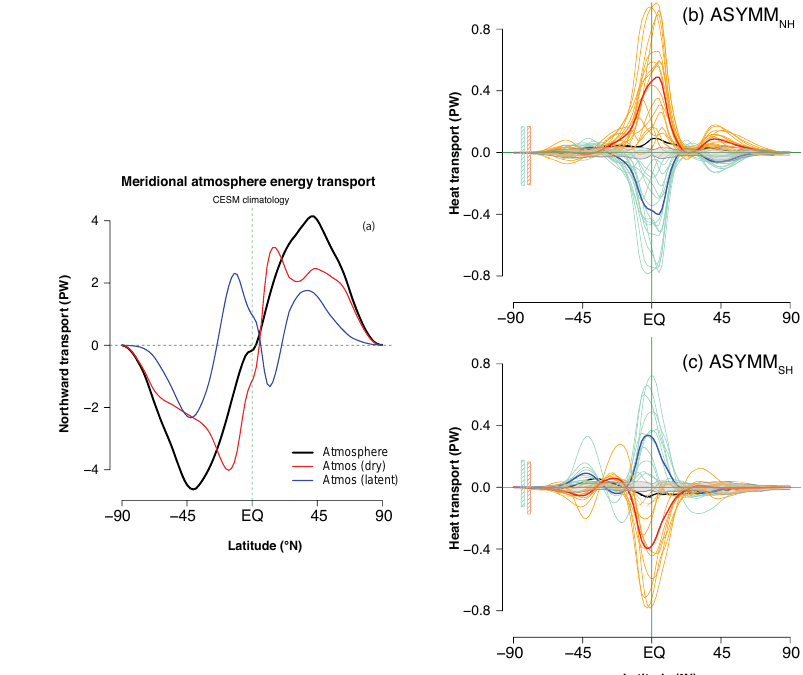
Figure 8. (a) CESM climatology of atmospheric energy transport (PW, black) and dry (red) and latent (dark blue) transports. (b) Composite mean anomaly in atmospheric heat transport for ASYMM NH eruptions in total (black), dry (red), and latent (blue) components. Lighter (orange and aqua) lines represent individual eruptions, each averaged over 17 ensemble members. (c) As in (b) , except for ASYMM SH eruptions. Grey envelope corresponds to the total AET anomaly vs. latitude in a control simulation using 50 realizations of a 17-event composite (17 “events” with no external forcing, corresponding to the size of the ensemble). Vertical bars correspond to the range of (aqua) latent and (orange) dry components of cross-equatorial energy transport (AET eq ) in the control